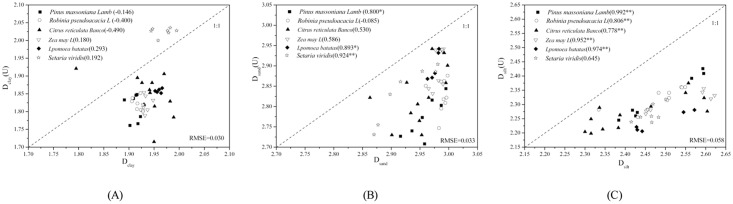
The comparison of the volume domain fractal dimension based on the measured Dvi and volume domain fractal dimension using USDA (Dvi(U)) land-use type classification.Footnote: the number in brackets represents the correlation coefficient; * indicates significant correlation (P<0.05), ** indicates significant correlation (P<0.01).